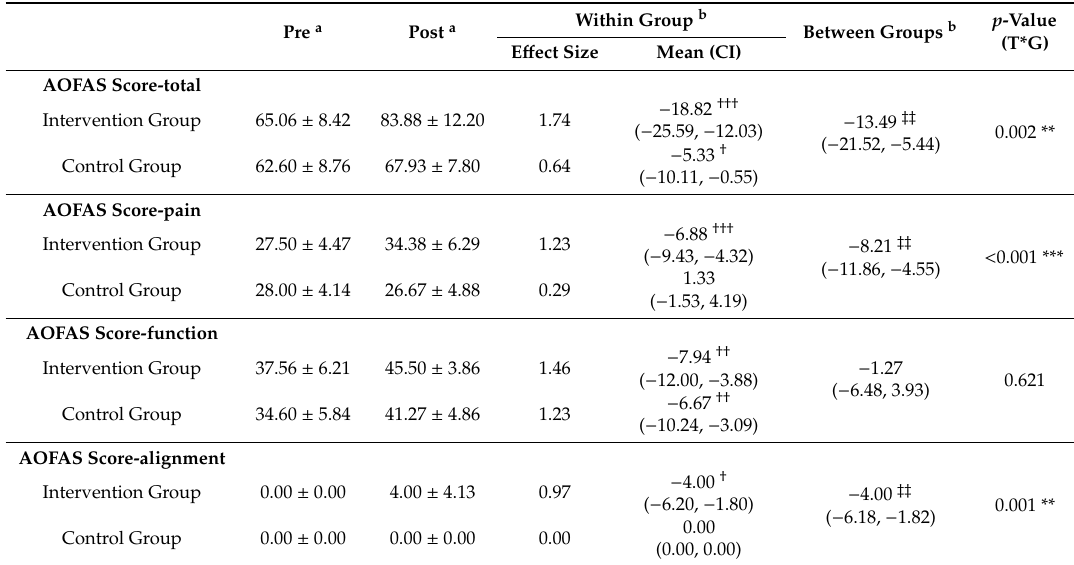
Table 2. The changes in AOFAS (American Orthopedic Foot and Ankle Society) scores.